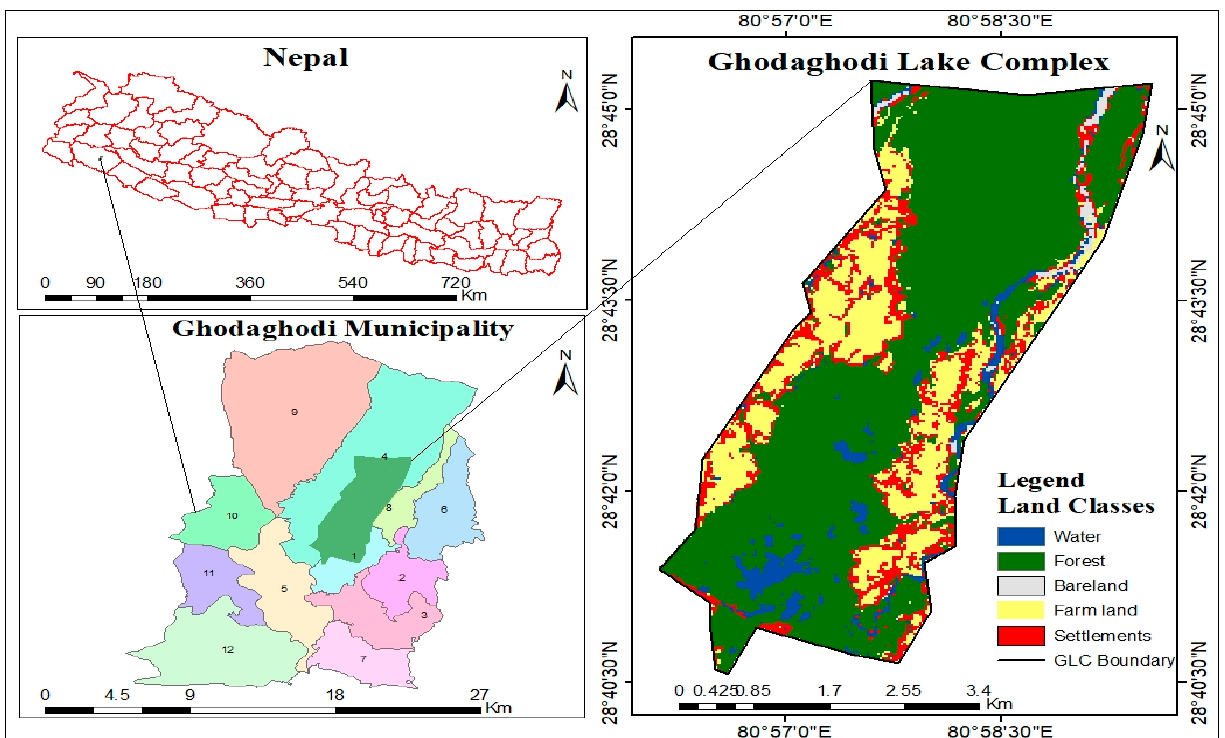
Figure 1. Location of Ghodaghodi Lake Complex (GLC) in the map of Nepal and its land use. Tharus are the indigenous and dominant people. The site received an annual rainfall of 1385 mm (about 4.54 feet) with an average monthly maximum temperature ranging from 18.8 degrees Celsius to 34.6 degrees and a minimum temperature ranging from 5.5 to 22.9 degrees Celsius in Tikapur (District Profile, 2021, unpublished report). The Chure Rural Municipality borders the Ghodaghodi Lake Complex in the north, Bardagoriya Rural Municipality in the east, Gauriganga Municipality in the west, and Vajani Municipality in the south (Division Forest Office, Pahalmanpur, Kailali, 2022, unpublished report). Ward numbers 1, 4, and 8 are immediate to the Ghodaghodi Lake area, with 39 settlements, of which 14 are in Ward 1, 13 are in Ward 4, and 12 are in Ward 8 (Divisional Forest Office, Pahalmanpur, Kailali, 2022). Tharu have been the significant inhabitants of the area for over two centuries [41]. Migrants from the mountainous region might create massive pressure on wetland resources, causing deforestation, encroachment in and around wetlands, and uncontrolled fishing and illegal hunting. Changes in demographic conditions affect the traditional use of resources. According to the Division Forest Office, Pahalmanpur, Kailali, “The lake complex is surrounded by 11 community forests and two main rivers, Doda to the east and Kauwa to the